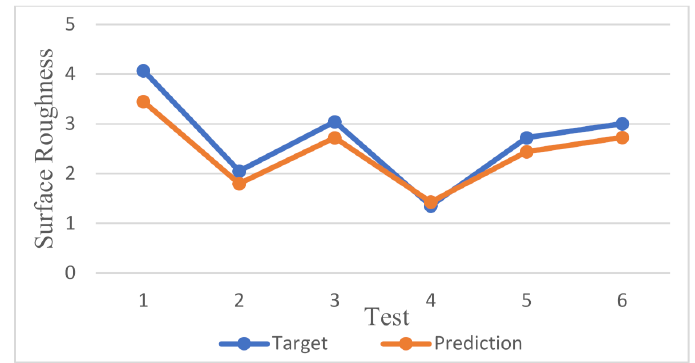
Figure 13. Target and predicted results of